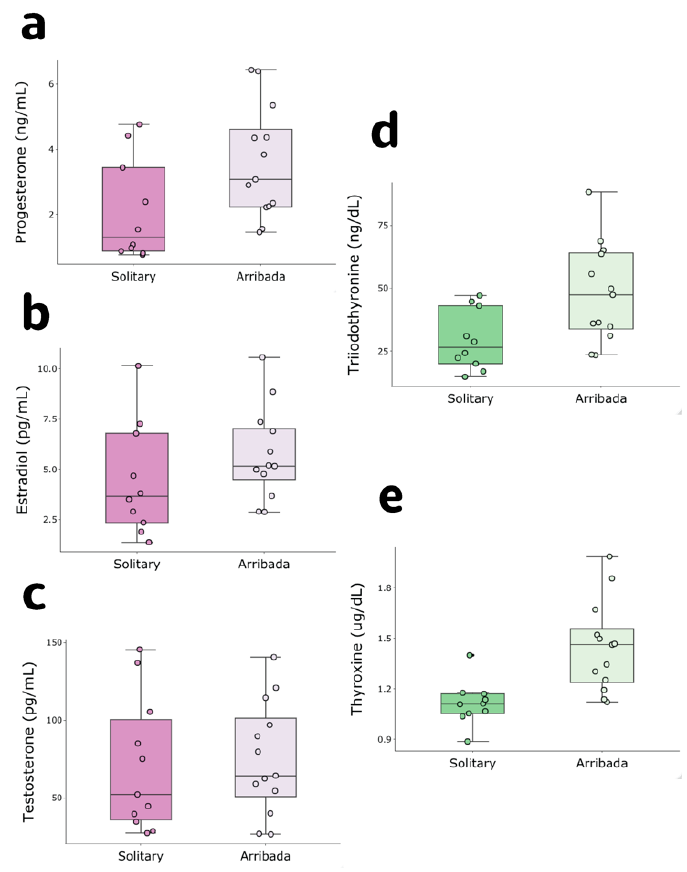
Figure 1. Reproductive and metabolic hormone levels in solitary and arribada nesters. ( a ) Proges- terone ( p = 0.02), ( b ) estradiol ( p = 0.25), ( c ) testosterone ( p = 0.78), ( d ) triiodothyronine ( p = 0.015), and ( e ) thyroxine ( p = 0.002).